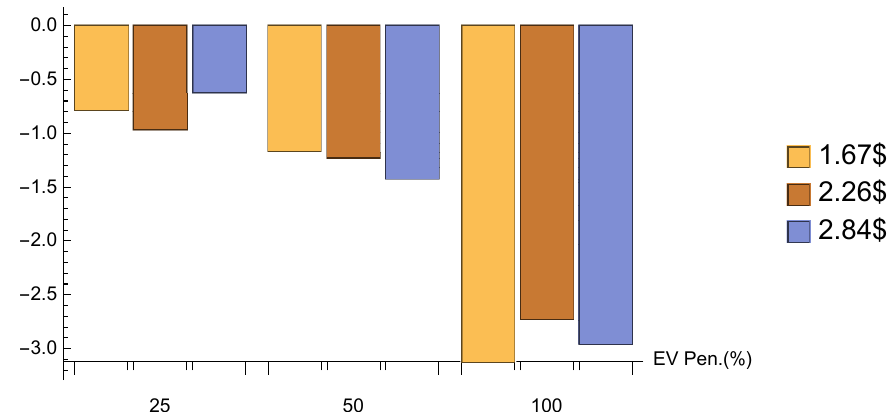
Figure 10. NPC variations for different EV penetration levels and diesel prices between cases B and C.